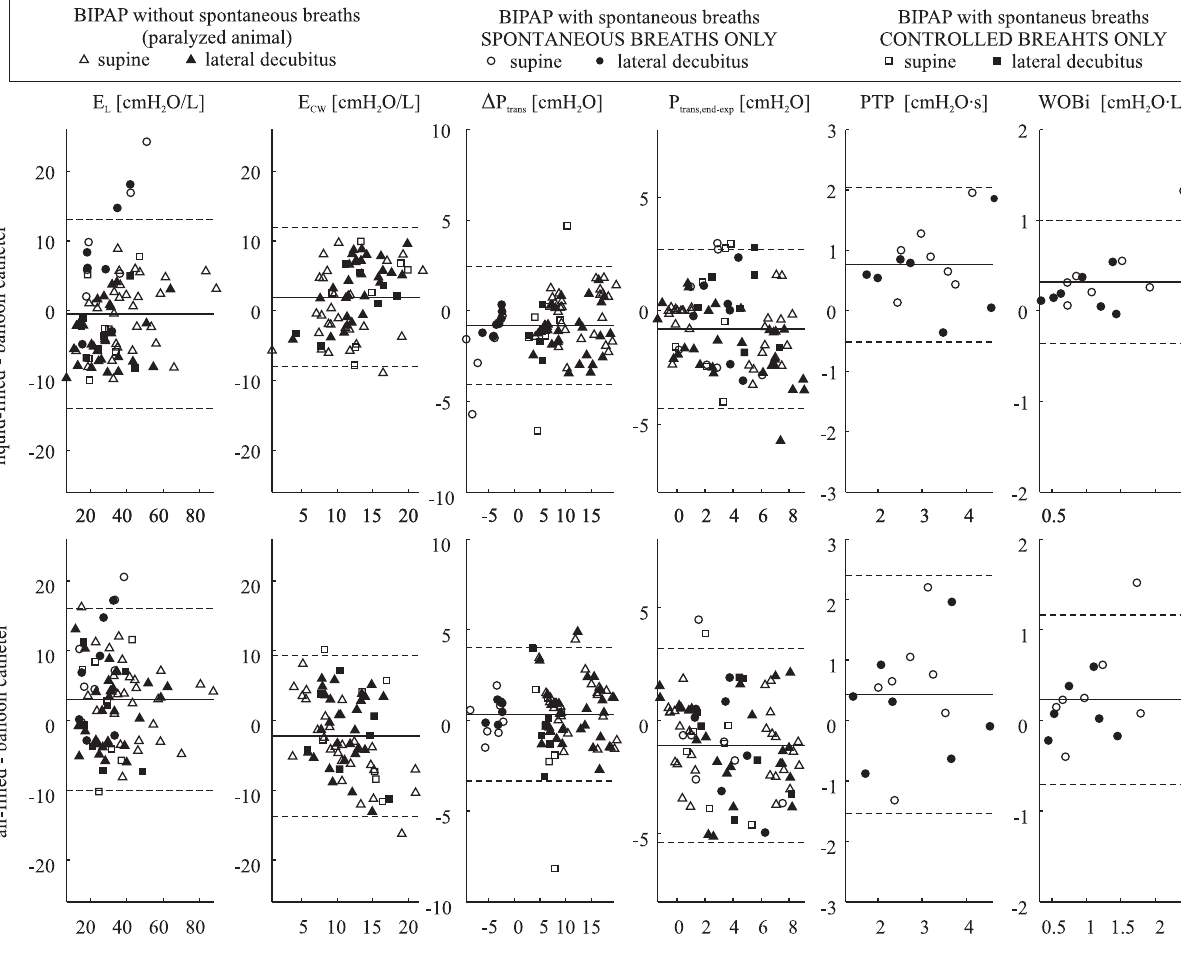
Figure 3. Bland-Altman plots comparing average parameters estimated using the balloon catheter measurement with those obtained using the air- or liquid-filled catheter, under different settings of BIPAP (biphasic positive airway pressure) mechanical ventilation. E L , E cw : lung and chest wall elastance; D P trans : inspiratory change in transpulmonary pressure; P trans,end-exp : end-expiratory value of transpulmonary pressure; PTP: pressure-time product; WOB i : inspiratory work of breathing. The horizontal lines represent the mean (solid line) 6 SD (dashed lines) of the difference between methods.